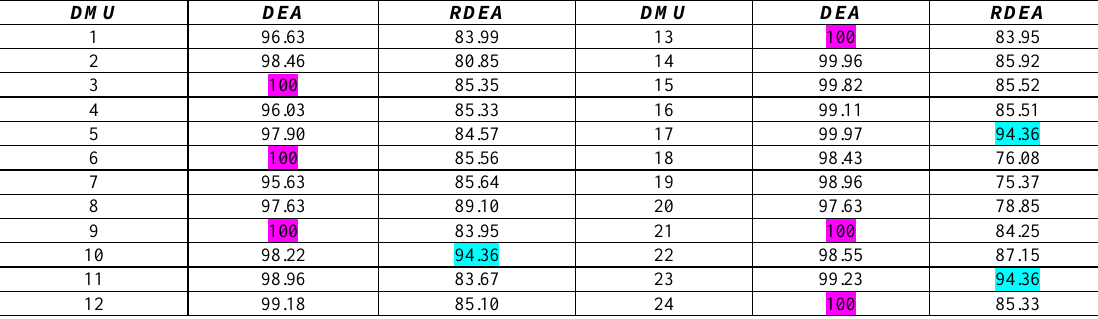
Table 3. Comparison the proposed